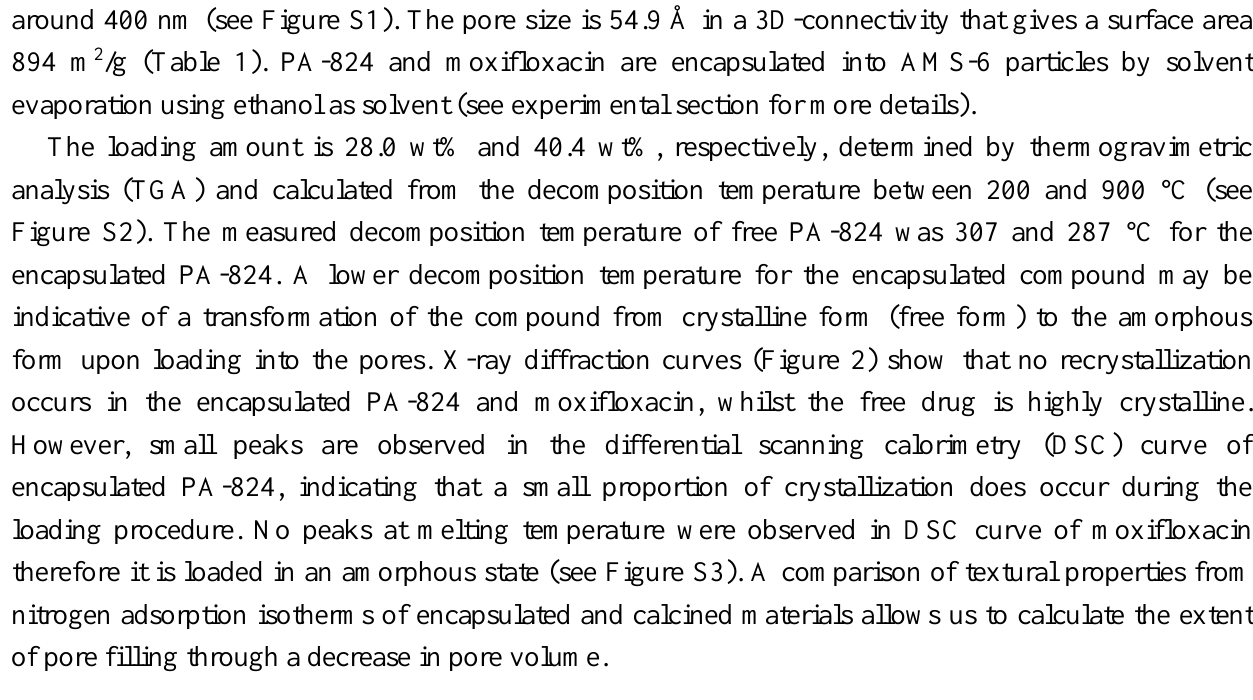
Table 1. Textural properties of calcined and encapsulated AMS-6